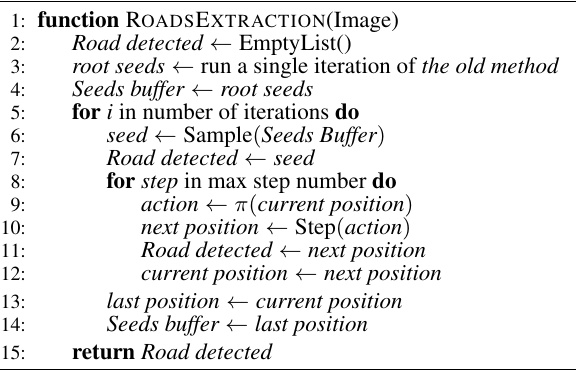
Algorithm 1 Hybrid Approach for Road